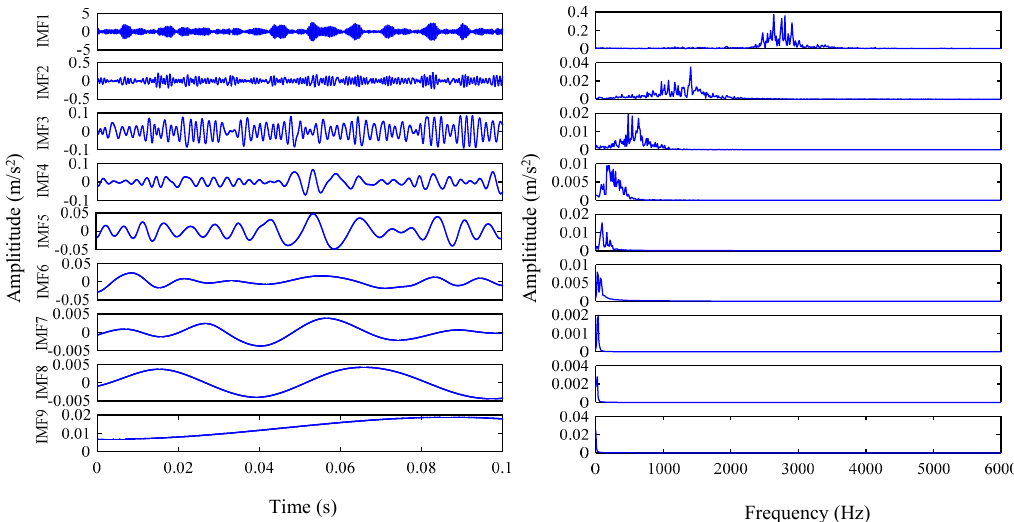
Figure 18. Decomposition results and corresponding frequency spectrum of the IMFs for outer ring defect using EMD.